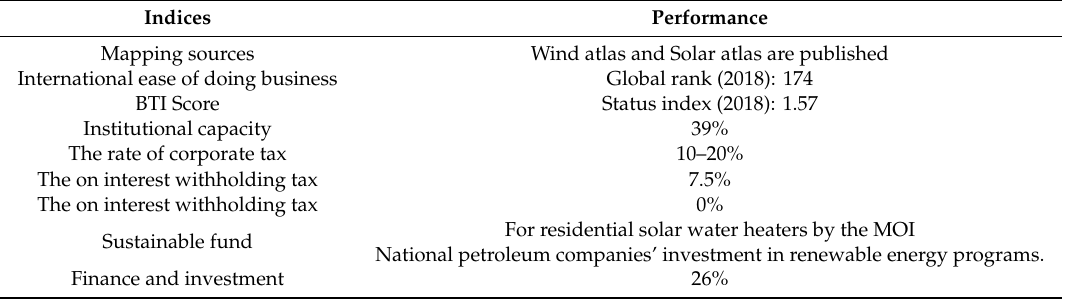
Table 8. The SEPS performance indices in terms of renewable